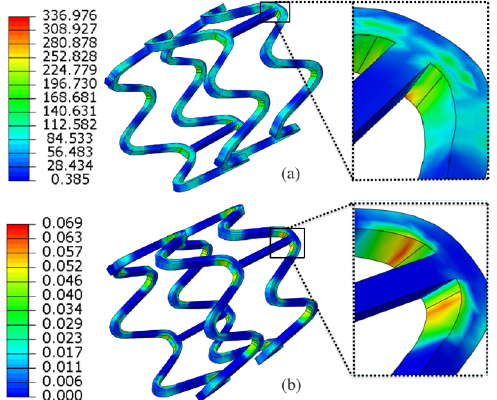
Figure 9. The equivalent stress ( a ) and equivalent strain ( b ) distribution of stent at the end of ex- pansion.